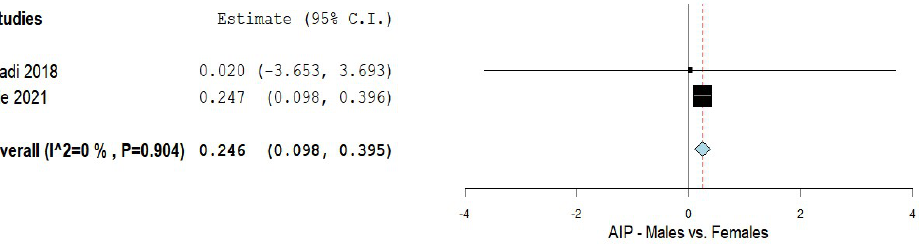
Figure 3. The AIP in the male vs. female NAFLD patients; AIP—Atherogenic index of plasma; NAFLD–Non-alcoholic fatty liver disease.